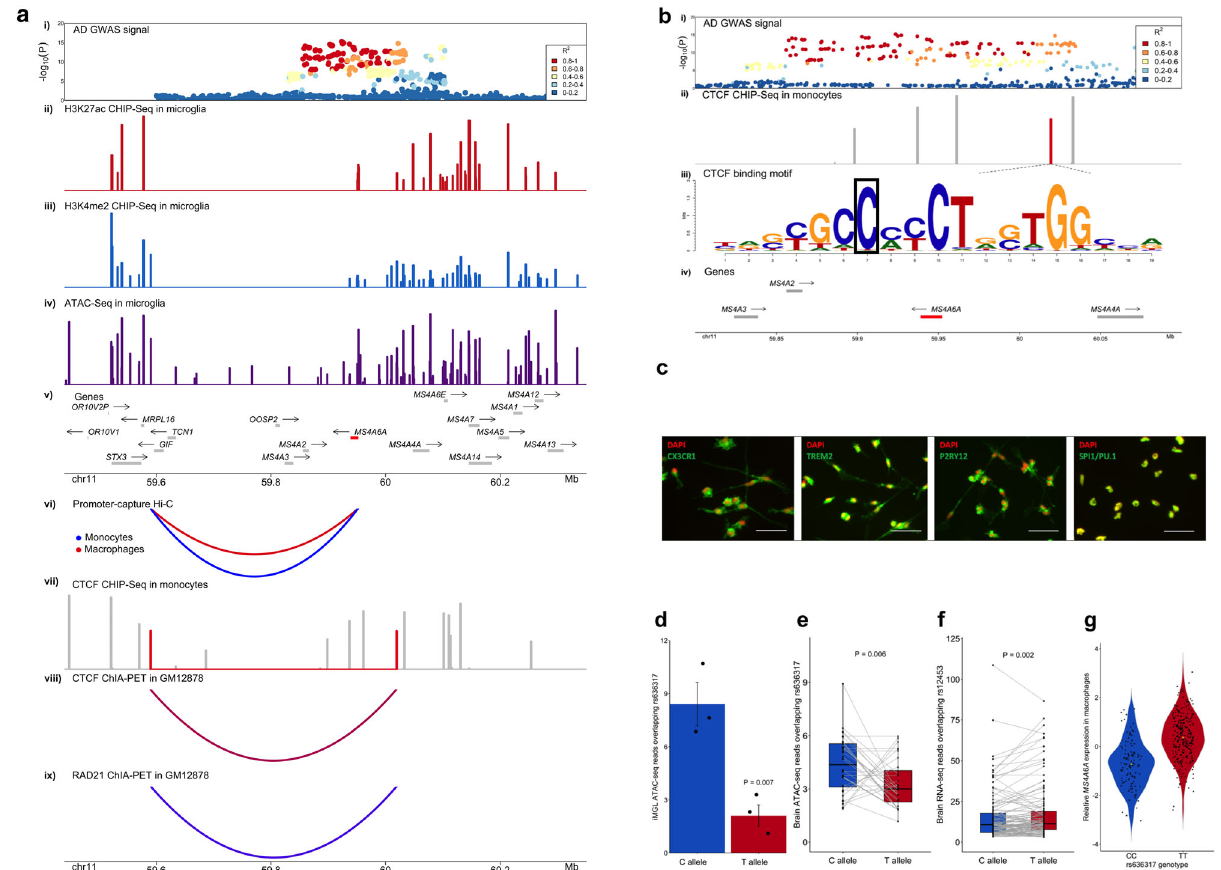
Fig. 4 A candidate causal variant in the MS4A locus disrupts an anchor CTCF binding site and is associated with reduced chromatin accessibility and increased MS4A6A gene expression in myeloid cells and in the brain. a (i) AD GWAS signal in the MS4A locus. (ii) H3K27ac peaks in microglia. (iii) H3K4me2 peaks in microglia. (iv) ATAC-seq peaks in microglia. (v) Genes that reside in the locus are plotted. Putative AD risk genes are highlighted in red. The arrow indicates the direction of transcription, while the bar indicates the gene body. (vi) Strongest promoter-capture Hi – C interactions between the MS4A6A promoter and distal regulatory elements contained within the CTCF loop in monocytes (blue) and macrophages (red). (vii) CTCF ChIP-Seq peaks in monocytes. The peaks highlighted in red are anchor CTCF binding sites for the chromatin loop. (viii) CTCF ChIA-PET interactions in GM12878. (ix) RAD21 ChiA-PET interaction in GM12878. b (i) AD GWAS signal in the MS4A locus. (ii) CTCF ChIP-Seq peaks in monocytes. The peak highlighted in red is an anchor CTCF binding site for a chromatin loop and contains the candidate causal variant (rs636317-T). (iii) A CTCF binding motif resides in the CTCF ChIP peak highlighted in red in (ii). The candidate causal variant (rs636317-T) resides in position 7 (boxed) of this motif and is predicted to disrupt CTCF binding. (iv) Genes that reside in the locus are plotted. Putative AD risk genes are highlighted in red. The arrow indicates the direction of transcription, while the bar indicates the gene body. c Immuno fl uorescent images of microglial markers (CX3CR1, TREM2, P2RY12 and PU.1) con fi rming differentiation of hiPSC-derived microglia. Scale bar = 100 μ m. d Allelic imbalance of chromatin accessibility at the rs636317 site is observed in hiPSC-derived microglia. Mean normalized ATAC-Seq read counts are plotted for the protective (C) and risk-increasing (T) alleles; the dots represent each individual, centers for the error bars represent mean normalized ATAC-seq read counts and error bars represent standard errors. The protective allele (C) shows signi fi cantly more ATAC-Seq read counts than the risk-increasing allele (T) ( P -value = 0.007, paired one-sided t-test), which is consistent with the hypothesis that the presence of the rs636317 AD risk-increasing allele leads to disruption of CTCF binding. e Allelic imbalance of chromatin accessibility at the rs636317 site is observed in the brain. Each pair of dots connected by a grey line represent an individual. The protective allele (C) shows signi fi cantly more ATAC-Seq read counts than the risk-increasing allele (T) ( P -value = 0.006, paired one-sided t-test, n = 32), which replicates our observations in hiPSC-derived microglia. f Allelic imbalance in normalized brain RNA-seq reads at rs12453 site. Each pair of dots connected by a grey line represent an individual. The protective allele (C) shows signi fi cantly less MS4A6A RNA-Seq read counts than the risk-increasing allele (T) ( P -value = 0.002, paired one-sided t-test, n = 118), which is consistent with our hypothesis. g Relative expression of MS4A6A in macrophages increases in a rs636317-T allele dose-dependent manner. Each dot represents the relative expression level of MS4A6A in each individual, while the yellow dot represents the median. Horizontal lines in box plots depict 25%, 50%, and 75% quantiles; lower whisker = lower hinge - 1.5*IQR; upper whisker = upper hinge +